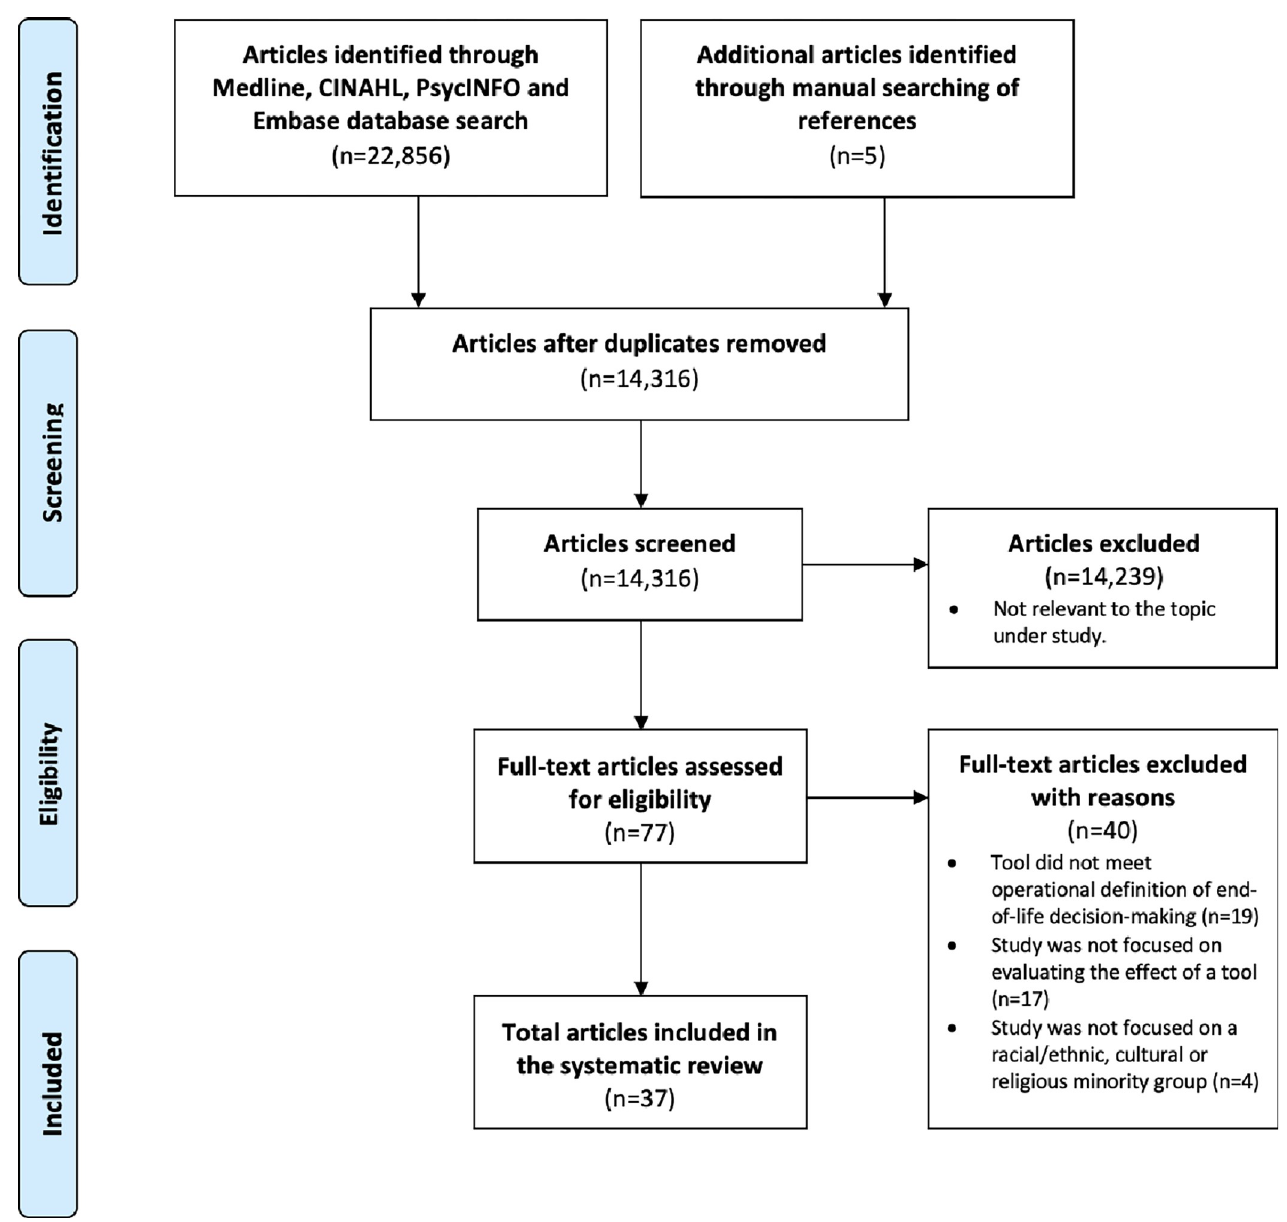
Fig 1. PRISMA screening